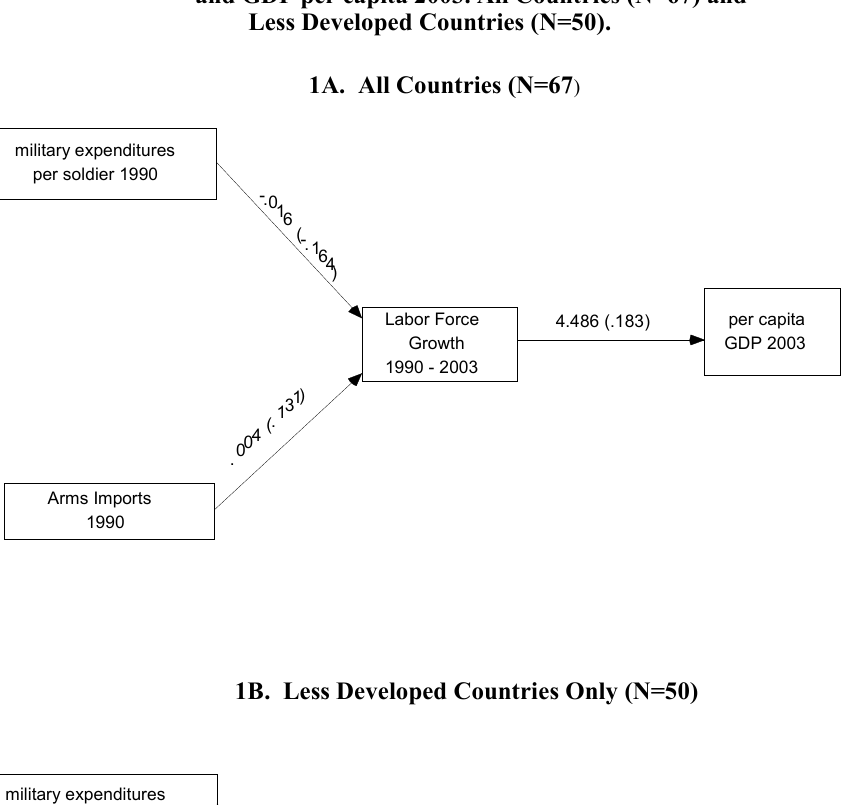
Figure 1. Causal Models of the Effect of Military Expenditures per Soldier and Arms Imports in 1990 on Labor Force Growth 1990-2003 and GDP per capita 2003. All Countries (N=67) and Less Developed Countries